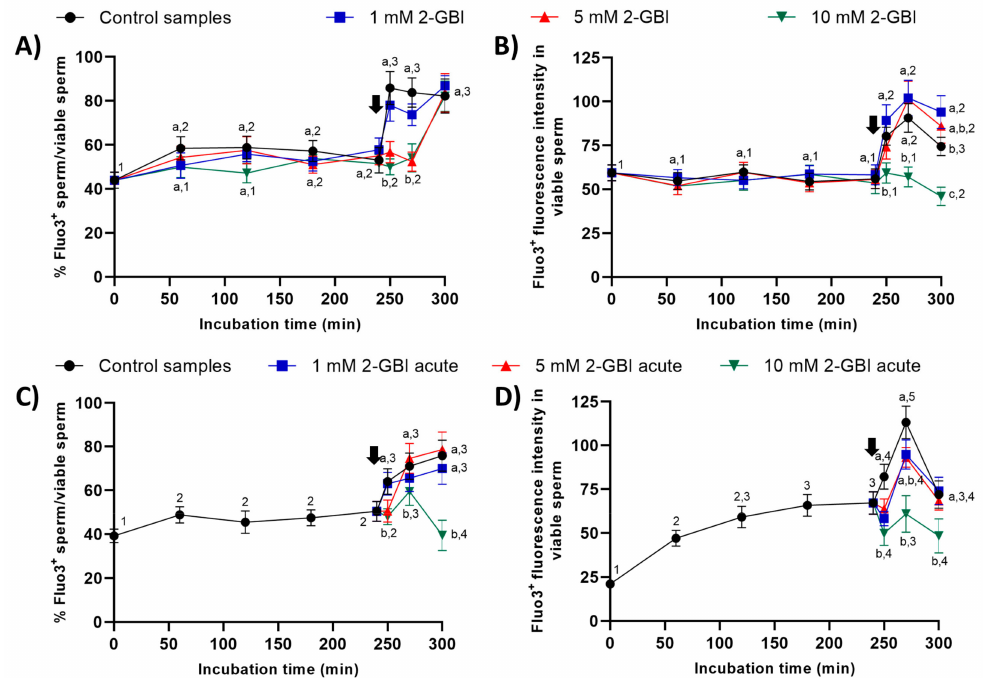
Figure 9. Percentages of viable sperm with high intracellular calcium levels evaluated through Fluo3 staining (Fluo3 + ) in relation to viable sperm (PI - ), and fluorescence intensity of Fluo3 + in viable sperm throughout incubation in capacitating medium (control samples) or capacitation medium plus 1 mM, 5 mM or 10 mM 2-GBI blocker, added at either 0 min in experiment 1 ( A , B ) or 240 min in experiment 2 ( C , D ; acute). Di ff erent superscript letters (a–c) indicate significant di ff erences ( p < 0.05) between samples within the same time point, and di ff erent superscript numbers (1–5) indicate significant di ff erences ( p < 0.05) between time points within a given treatment. Results are expressed as mean ± SEM ( n = 10). The arrow indicates the time at which 10 µ g / mL of progesterone was added to all samples (i.e., 240 min of